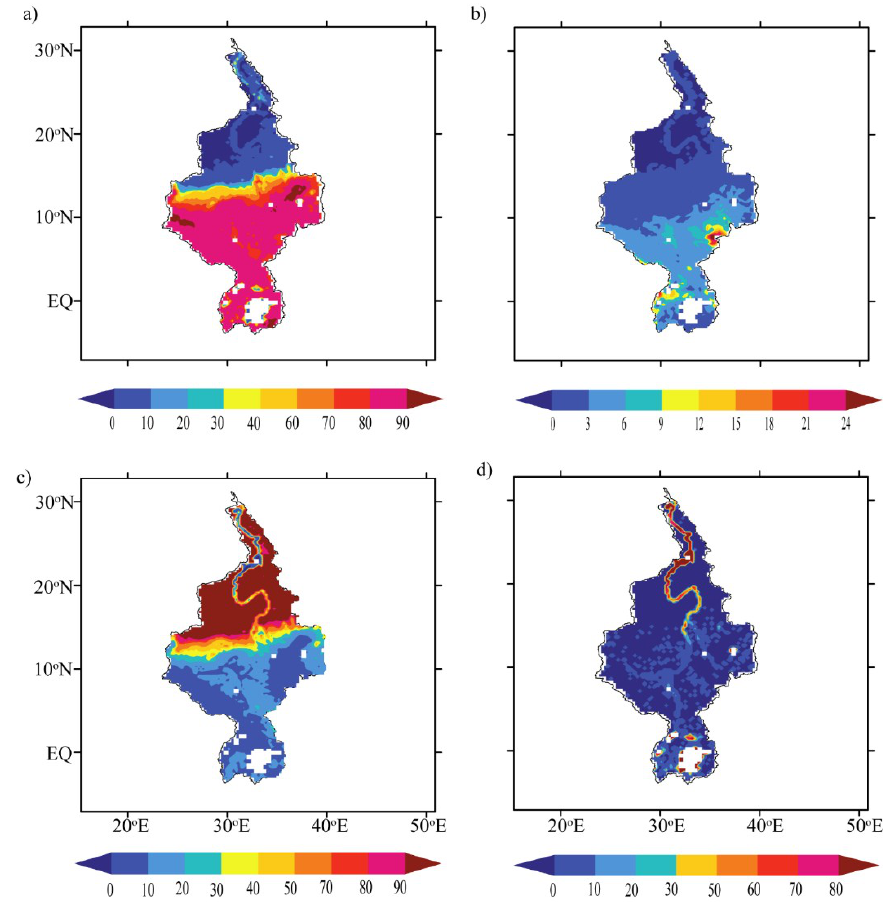
Figure 11. Seasonal amounts of different components of total ET in the Nile Basin for the period 1980–2014 (unit: mm): ( a ) E t , ( b ) E i , ( c ) E b , and ( d ) E w .